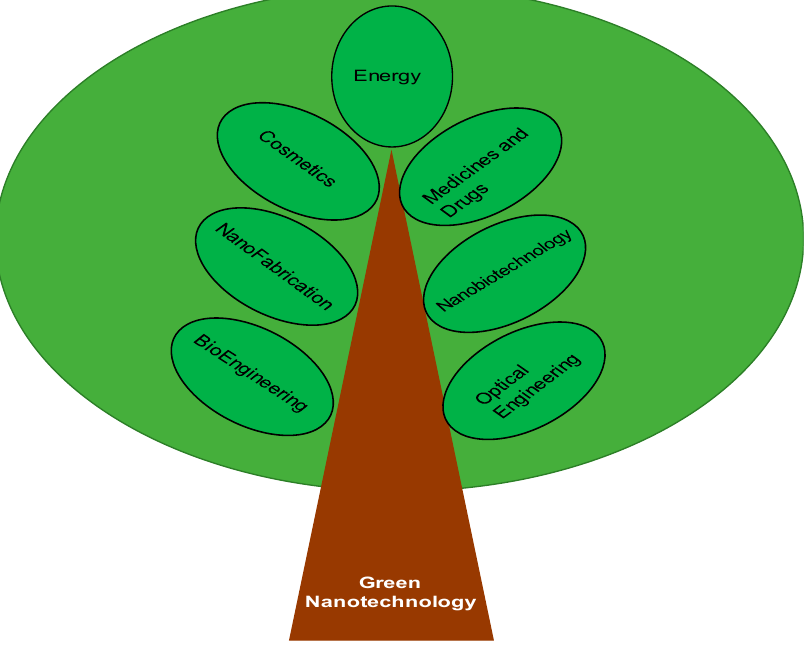
Figure 1. Branches of green nanotechnology.